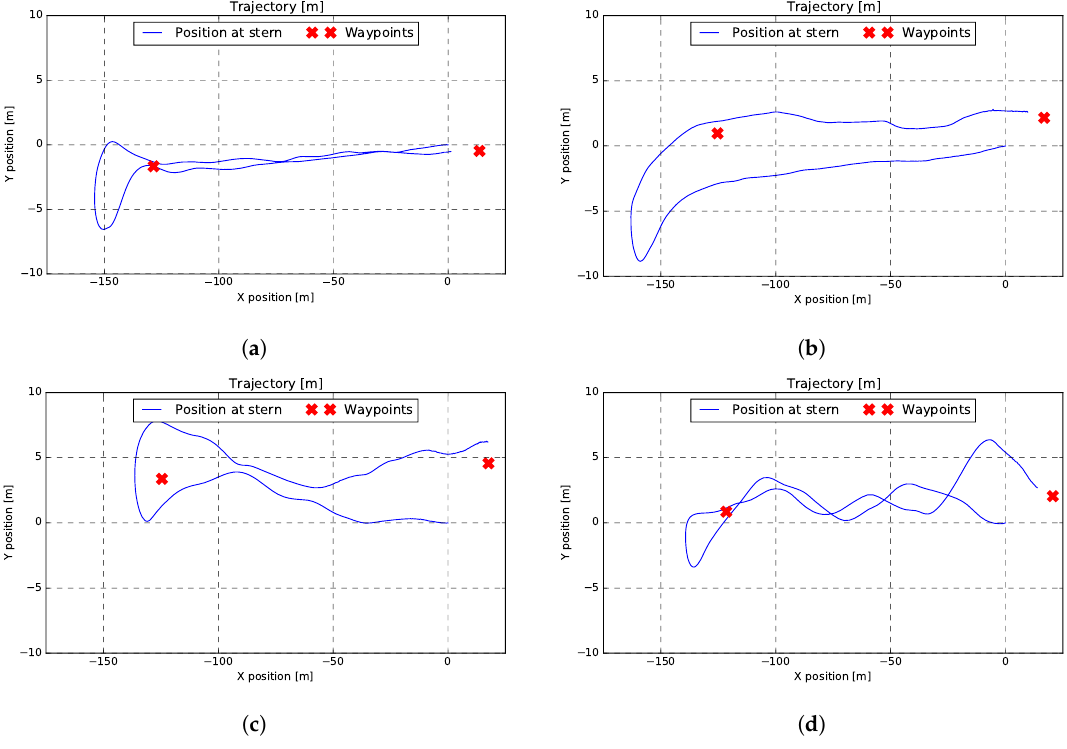
Figure 16. H2H-extended I-SCC straight sailing experiment with the USV in a canal (Leuven): ( a ) participant one, first run, with H2H-application ≈ 8.5 min, ( b ) participant one, second run, without H2H-application ≈ 10 min, ( c ) participant two first run, without H2H-application ≈ 7 min, and ( d ) participant two, second run, with H2H-application ≈ 6 min.